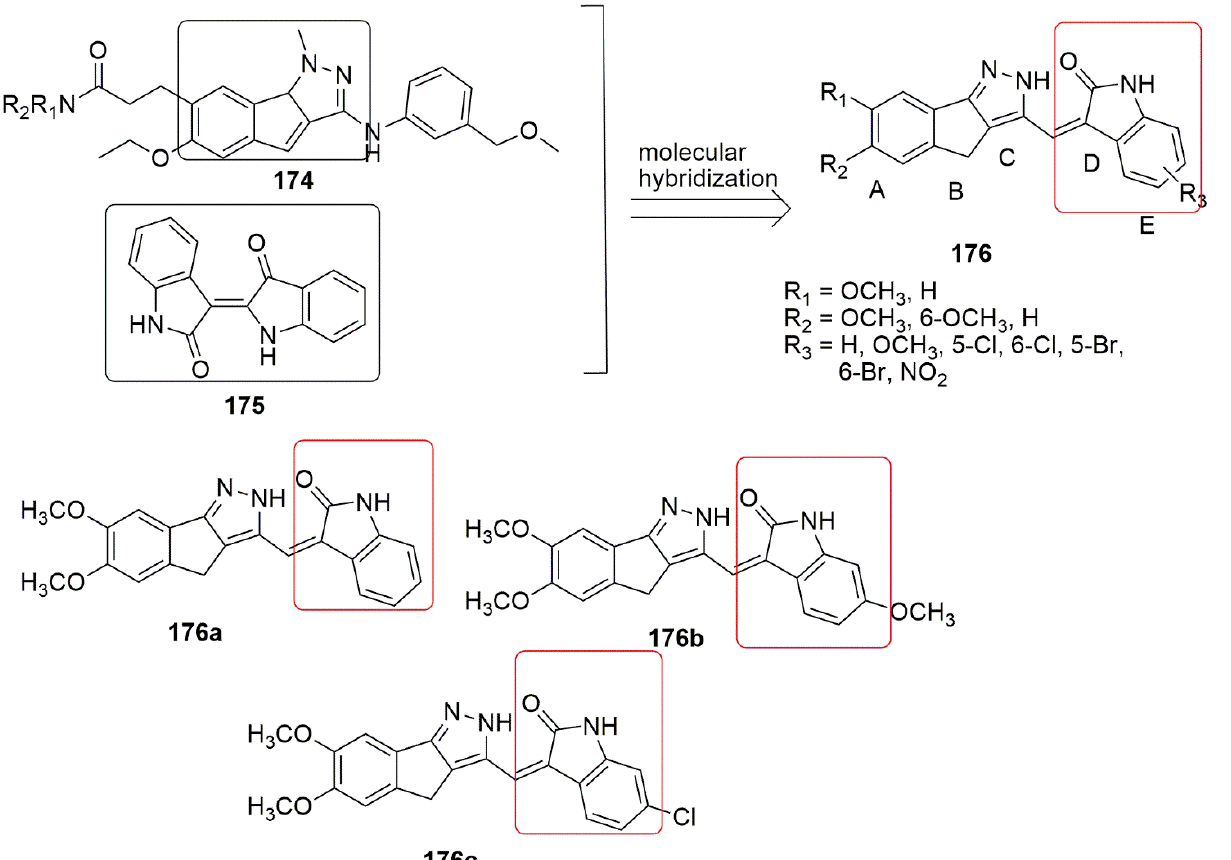
Figure 46. 1, 4-dihydroindeno-[1,2-c] pyrazole in combination with oxindole.